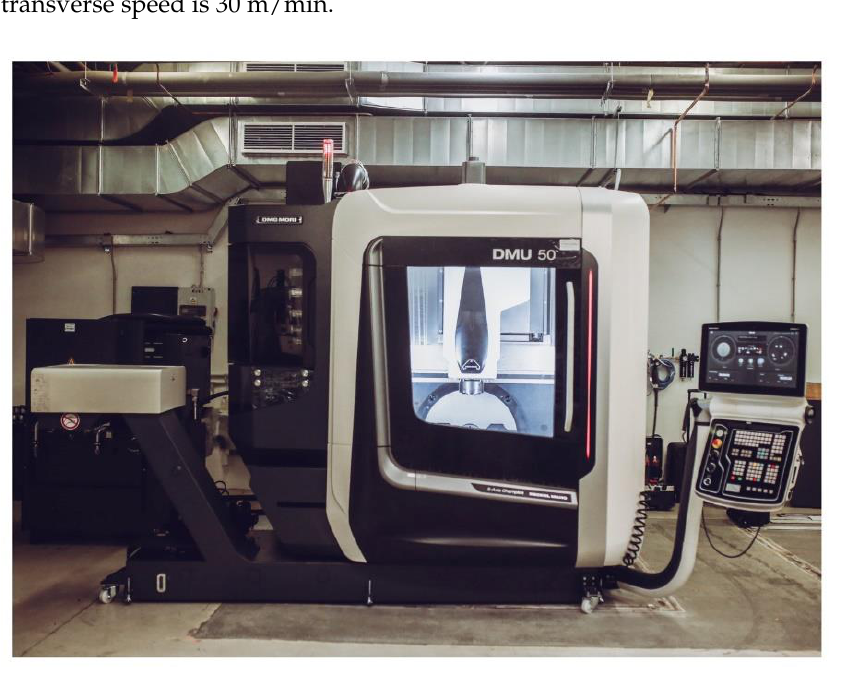
Figure 1. Five-axis vertical milling center DMU 50.